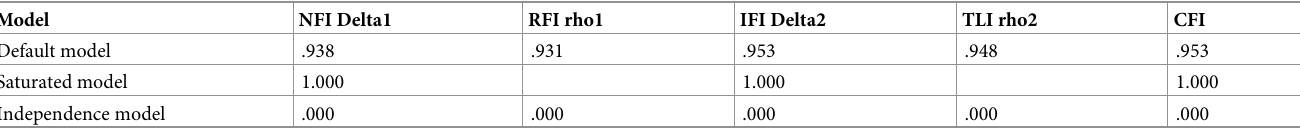
Table 3. Baseline comparisons 1.